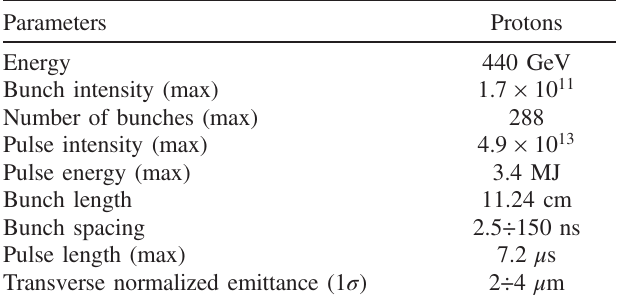
TABLE I. HiRadMat beam design parameters for protons.